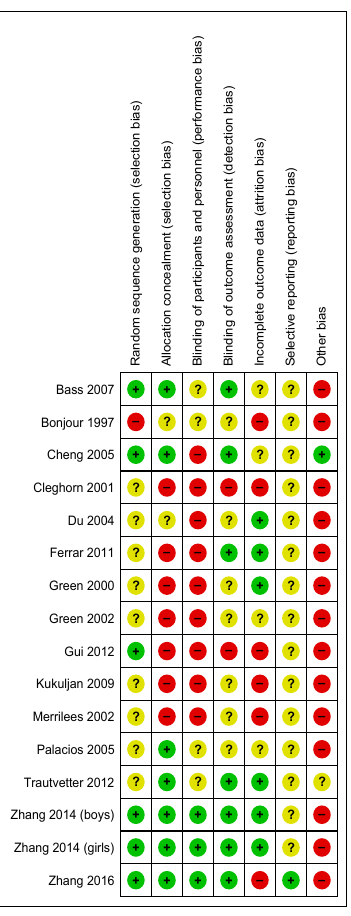
Figure 3. RCT risk of bias summary for included Randomised Controlled Trial [32–46].